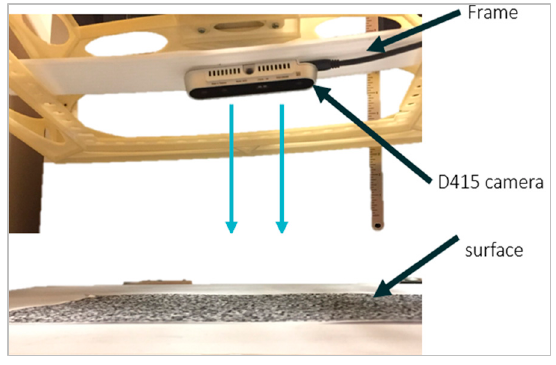
Figure 1. Test rig for D415.